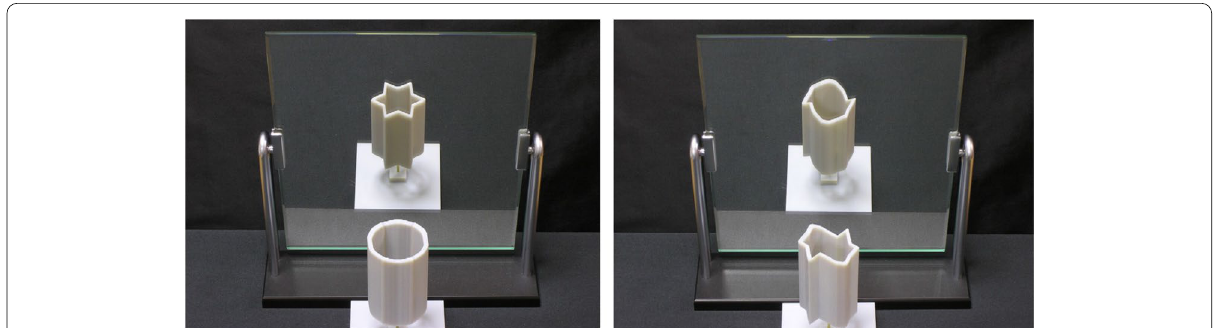
Fig. 16 By properly placing the object in front of the mirror, the user can see a totally different object in the mirror [29]